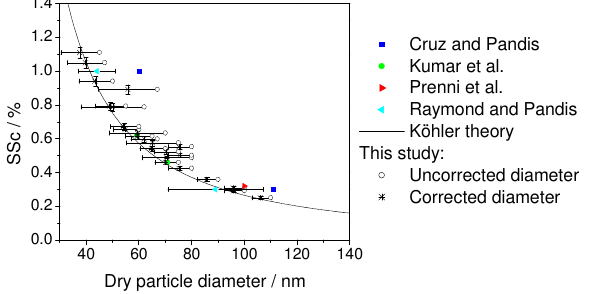
Fig. 10. The critical supersaturation of glutaric acid as a function of dry particle diameter (Cruz and Pandis, 1997; Prenni et al., 2001; Raymond and Pandis, 2002; Kumar et al., 2003). The experimental data is compared to K¨ohler theory (surface tension of pure water, dissociation calculated from the first acid constant).